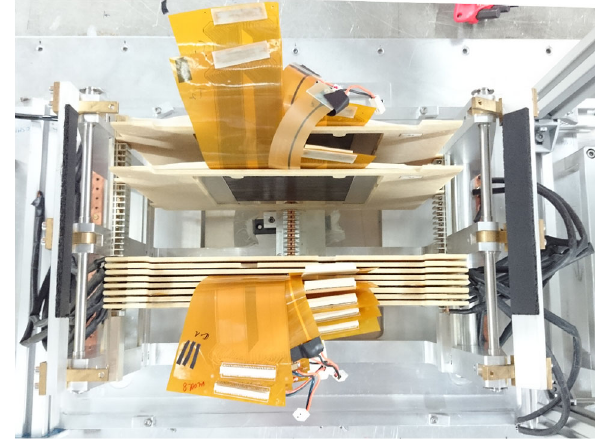
Fig. 6 Top view of the assembled calorimeter